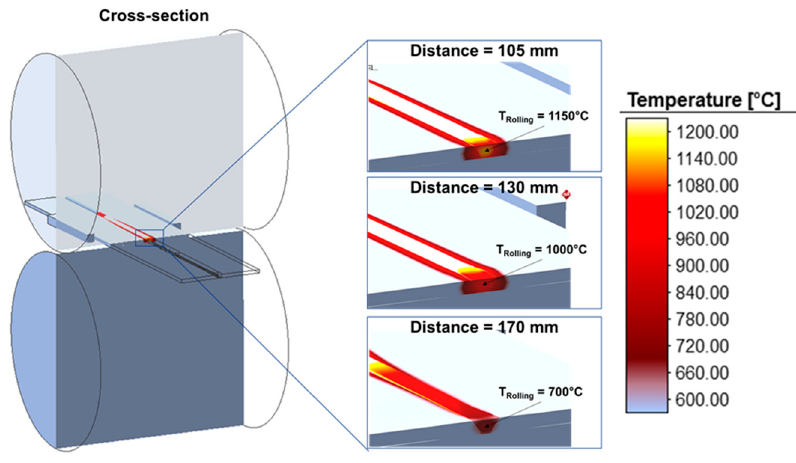
Figure 20. Temperature distribution in the rolling gap.